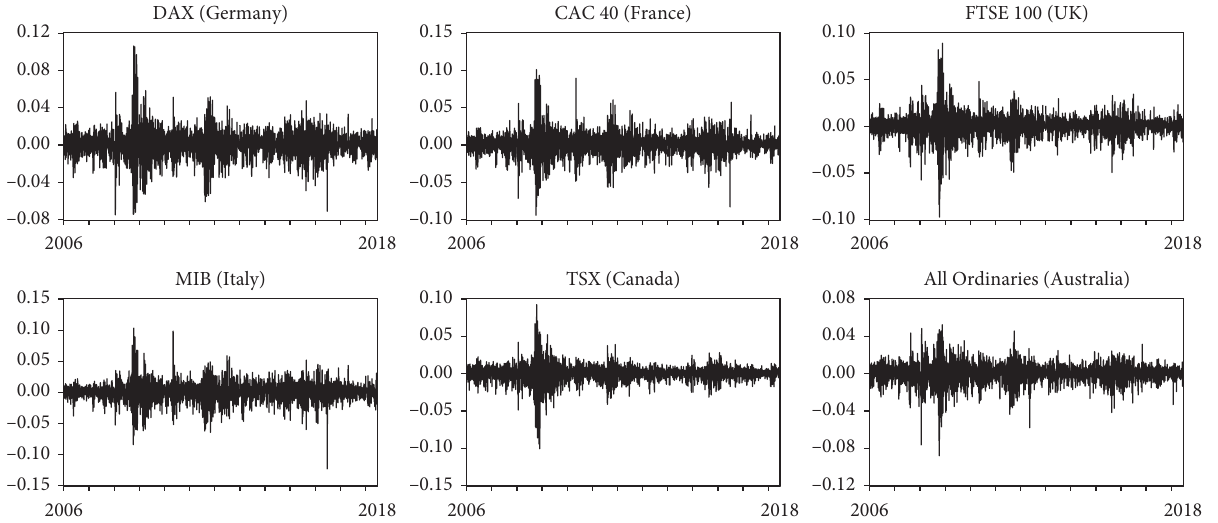
Figure 5: The residual series given by the ARMA-APARCH-M model. (a) DAX (Germany), (b) CAC 40 (France), (c) FTSE 100 (UK), (d) MIB (Italy), (e) TSX (Canada), and (f) All Ordinaries (Australia).